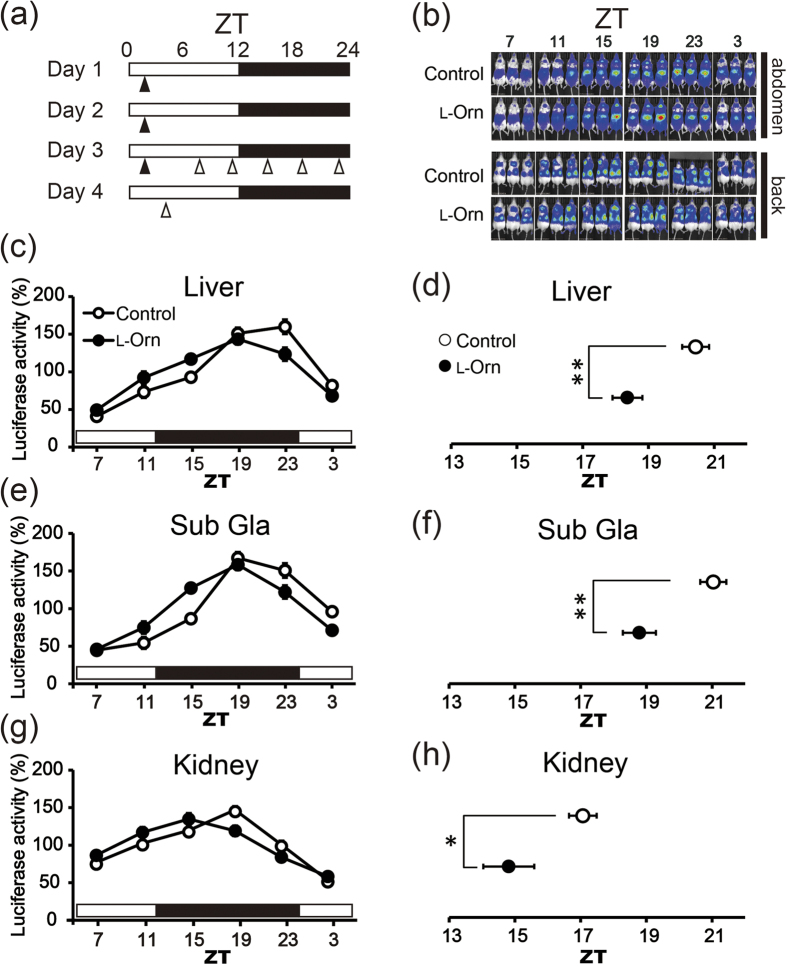
L-ornithine administration at Zeitgerber time 1 (ZT 1) causes a phase advance of PER2 rhythm, as evaluated by in vivo monitoring.(a) Experimental schedule. Open and filled bars indicate light and dark periods, respectively. At ZT 1, l-ornithine (1,000 mg/kg) or vehicle was administered to mice for three consecutive days by oral injection (filled arrowhead). Luciferase activity was measured six times every four hours (open arrowheads). (b) Representative photographs from each time point at 4-h intervals (three PER2::LUC mice were assessed simultaneously per time point). Upper panels show the ventral position with images of the liver and sub gla; lower panels show the prone position with images of the kidney. (c,e,g) Oscillatory PER2::LUC bioluminescence in the liver, sub gla and kidney of mice treated with l-ornithine (filled circles) or vehicle (open circles) (mean ± SEM: n = 15 mice, l-ornithine; n = 12 mice, vehicle). (d,f,h) Average peak phase of PER2::LUC bioluminescence in the liver, sub gla and kidney calculated by the cosinor procedure program. *P < 0.05, **P < 0.01 versus control (Mann-Whitney U test).